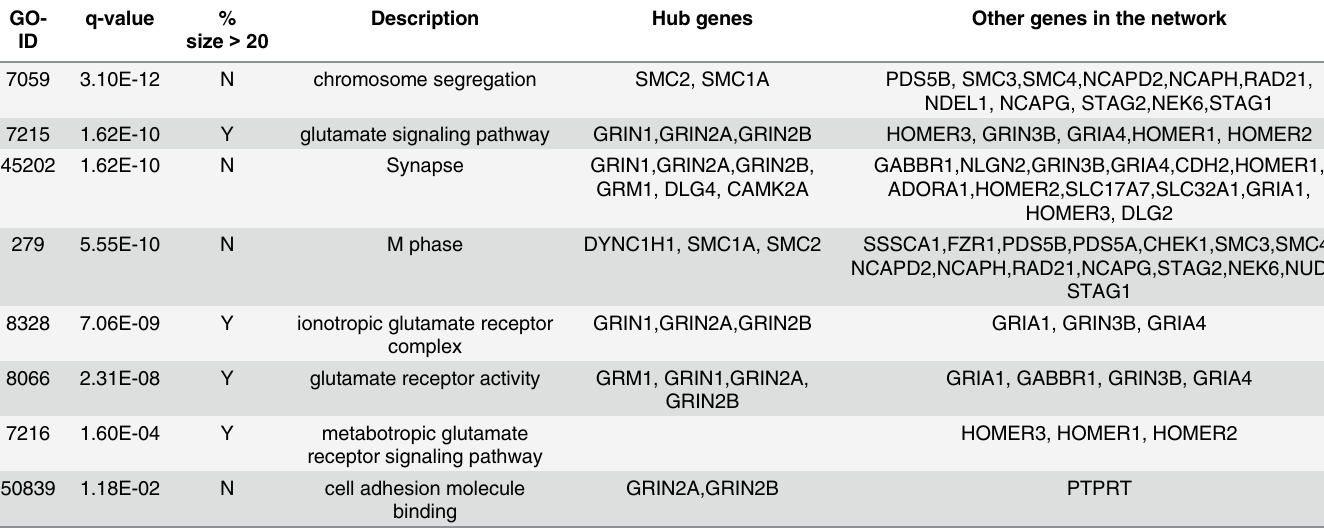
Table 4. GO enrichment analysis of Stage-II network.